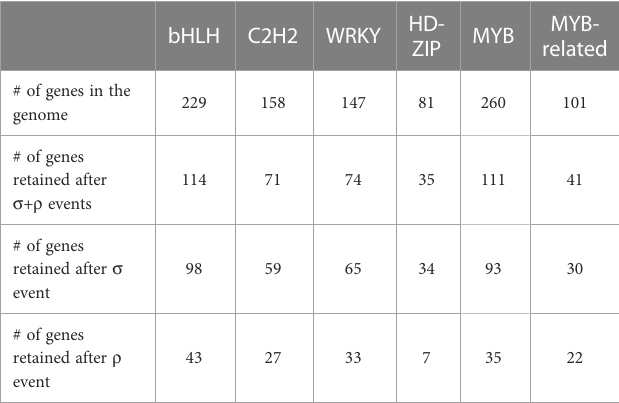
TABLE 4 The number of genes in the genome and the number of genes retained after two WGDs ( s and r events) for six transcription factor families in Melastoma candidum .